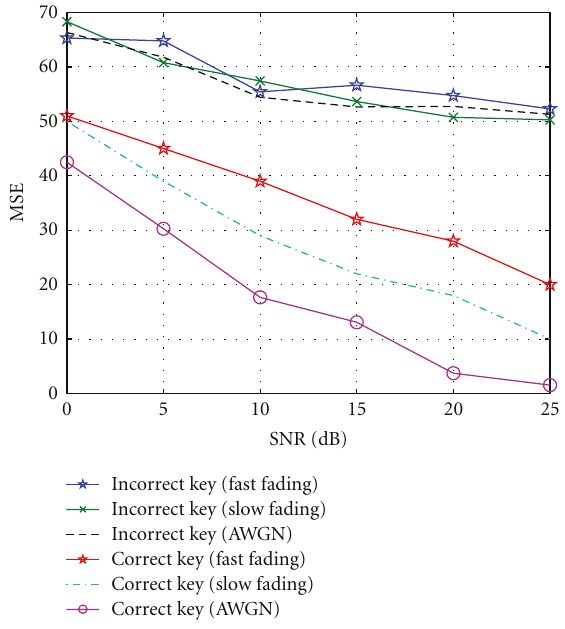
Figure 4: Data scrambling under fading channels.